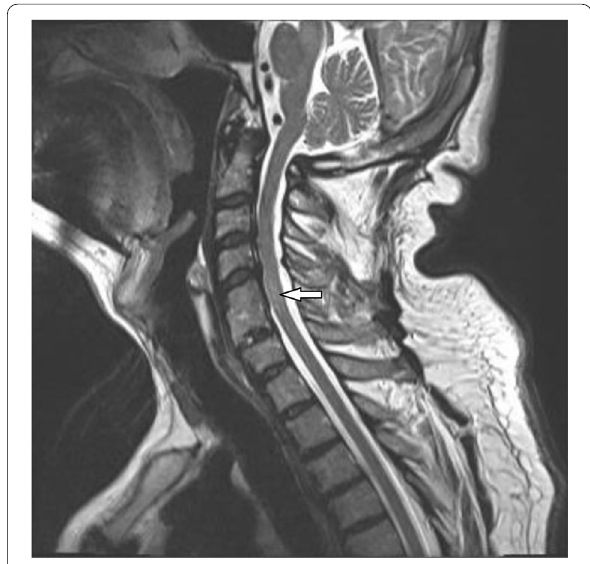
Fig. 3 Postoperative second year control, T2-weighted, sagittal section of vertebra MRI: the arrow shows the myelopathic signal changes of the spinal